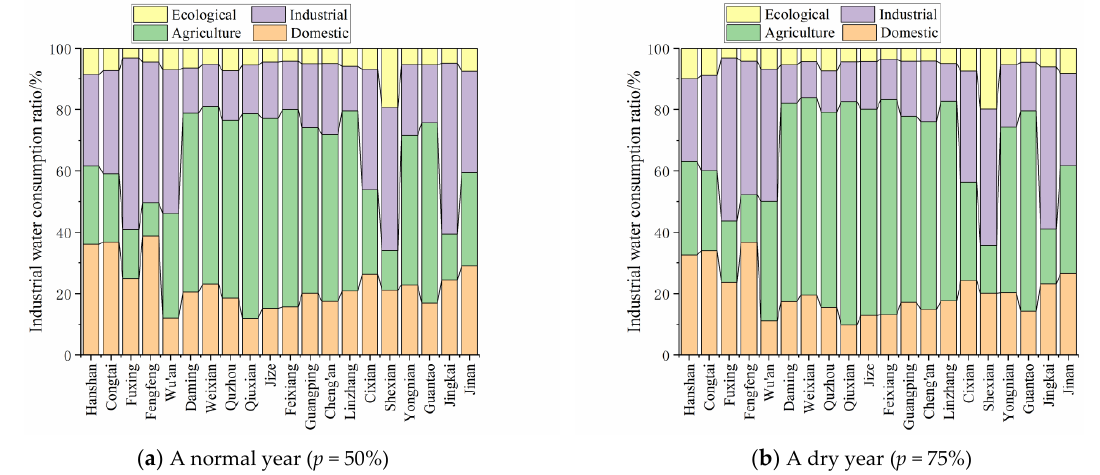
Figure 3. Prediction of water demand in 2035.